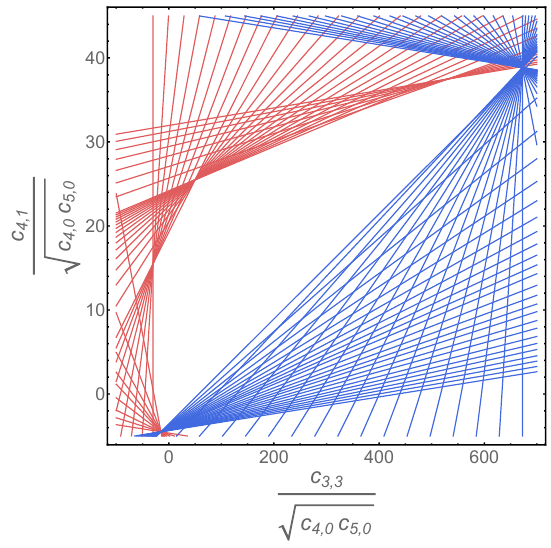
√ √ c 4 , 0 c 5 , 0 and c 4 , 1 / c 4 , 0 c 5 , 0 . The red (blue) lines are the D stu